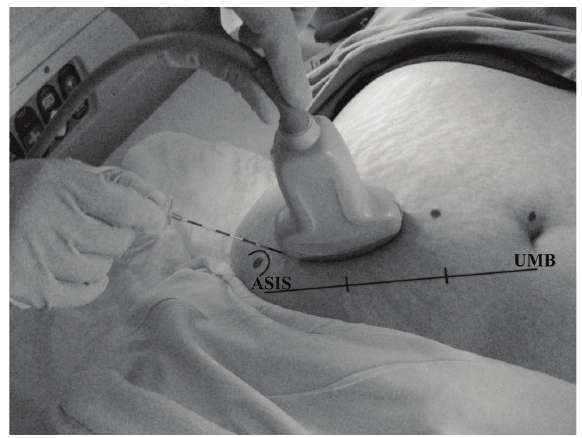
Figure 2: Photograph showing surface anatomy with needle and US-probe orientation. line joins anterior superior iliac crest (ASIS) to umbilicus (UMB).